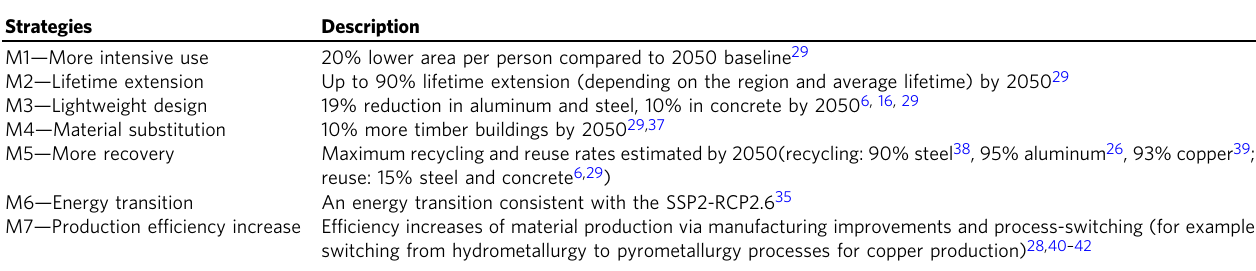
Table 1 Mitigation strategies for reducing emissions from materials required for buildings